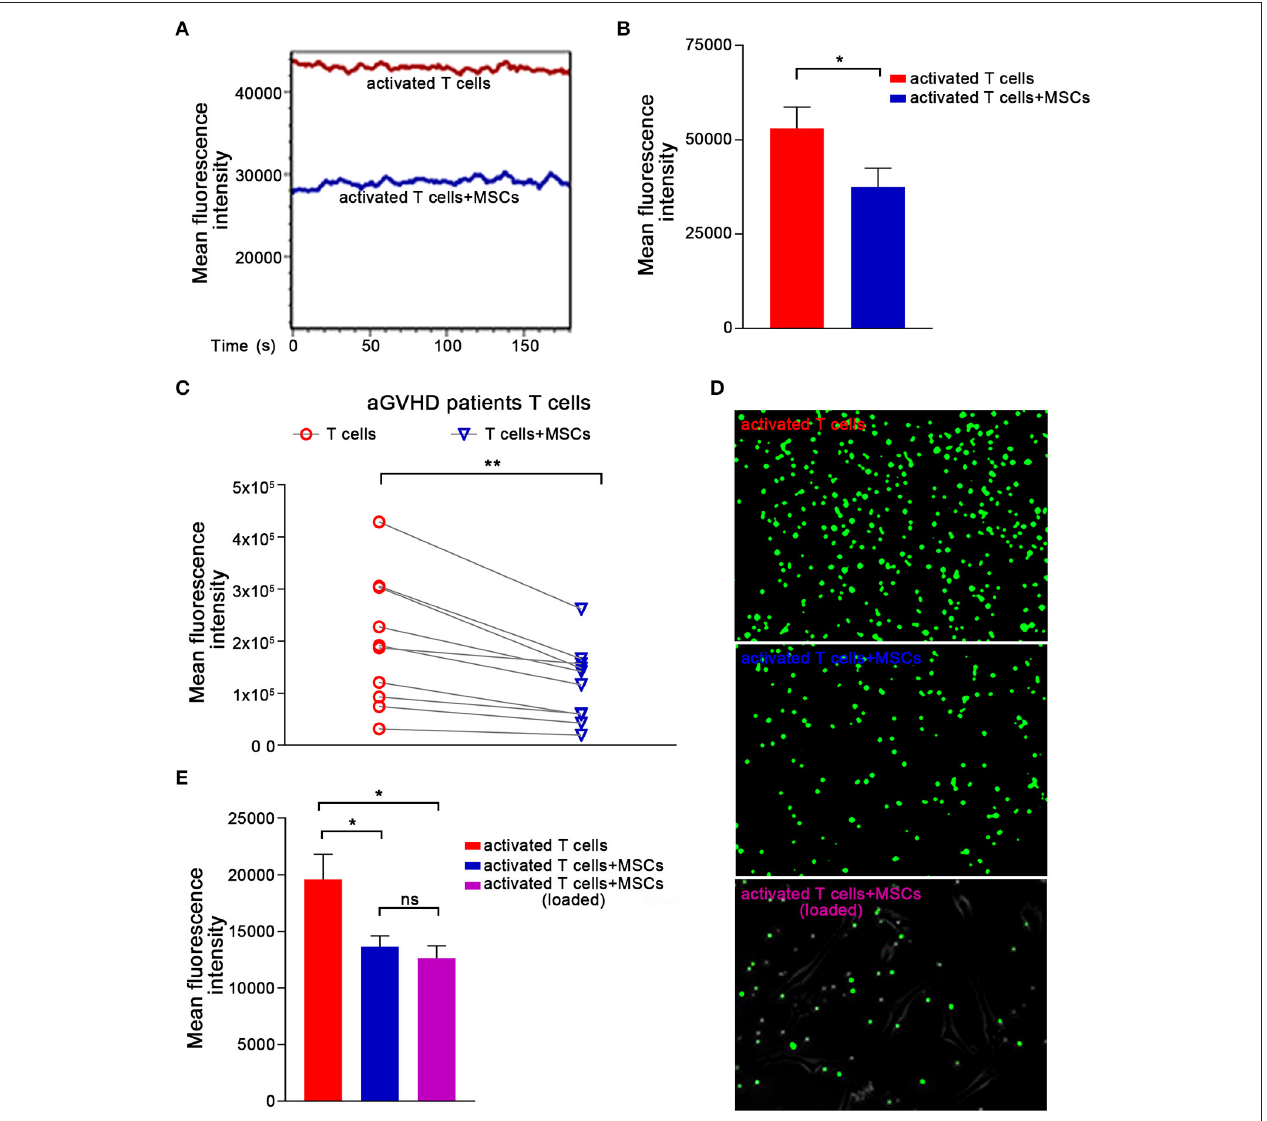
FIGURE 2 | The Ca 2 + signaling in activated T cells are rapidly abrogated by MSCs. (A) T cells were stimulated with CD3mAb and CD28mAb for 1h, labeled with the Ca 2 + -sensitive dye Fluo-4 AM, and then cocultured with MSCs for 1h. Activated T cells were analyzed via flow cytometry to monitor dynamic changes in cytosolic Ca 2 + levels. Data are representative of 10 donors. (B) Column chart shows the mean fluorescence intensity (MFI) of the activated T cells described in (A) . Data are presented as the means ± SEM from 10 donors. (C) T cells from patients were labeled and cocultured as described in (A) and assessed by flow cytometry. The data represented were from 10 patients. (D) Plates were pre-coated with poly-lysine, loaded (or not) with MSCs, and Ca 2 + indicator-loaded activated T cells were added and allowed to adhere. T cells (top), T cells removed from the coculture (middle), or those that adhered to the plated MSCs (lowest) are shown. Representative photos were taken by under a live-cell microscope. (E) Column displaying the mean fluorescence intensity (MFI) of the activated T cells and MSCs-cocultured activated T cells described in (D) . Data are presented as the means ± SEM from three donors. Significant differences are indicated as follows: ns, no statistical significance; * p < 0.05, and ** p <